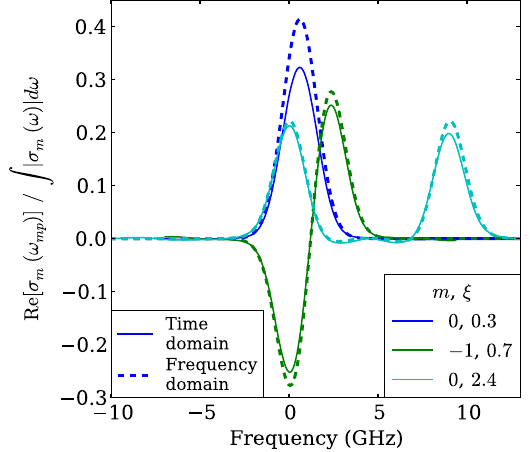
FIG. 8. Transverse bunch spectra for the short bunch case for the dominant mode at three different chromaticities. Time domain and frequency domain results are compared.